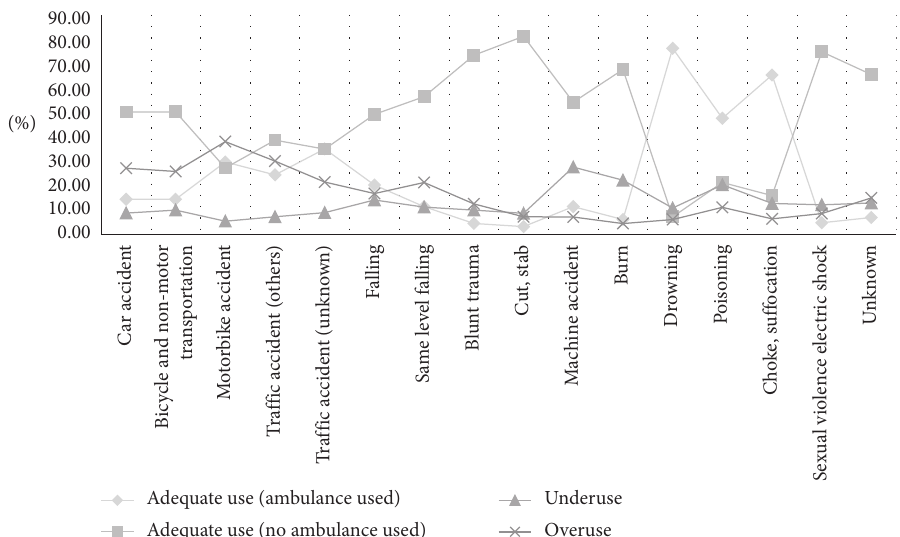
Figure 2: Comparison by the mechanism of injury. Regarding the mechanism of injury, there are higher rates of overuse in cases due to the traffic accident-related group.